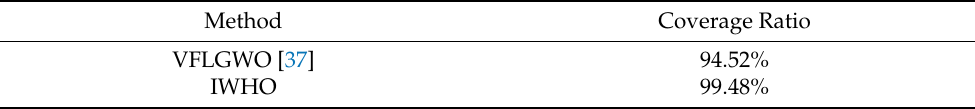
Table 13. Comparison of VFLGWO and IWHO experimental results.